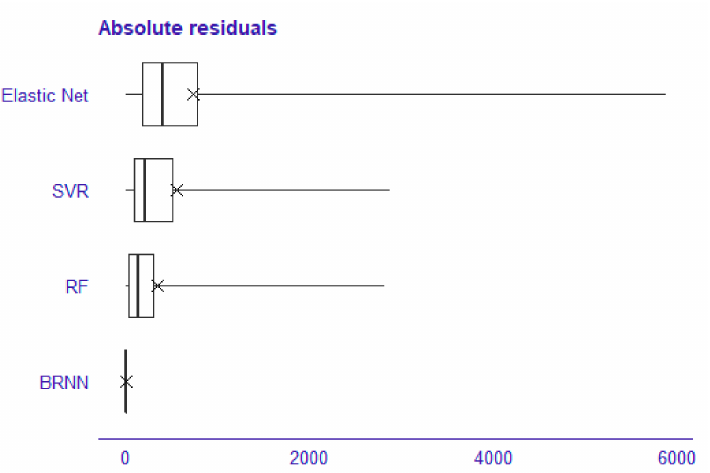
Figure 6. Residual